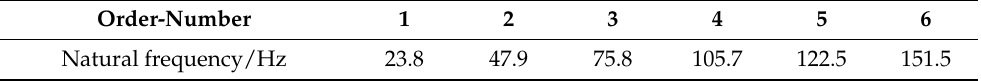
Table 1. Natural frequency of the non-running propulsion shafting under the linear alignment state. Order-Number 1 Natural